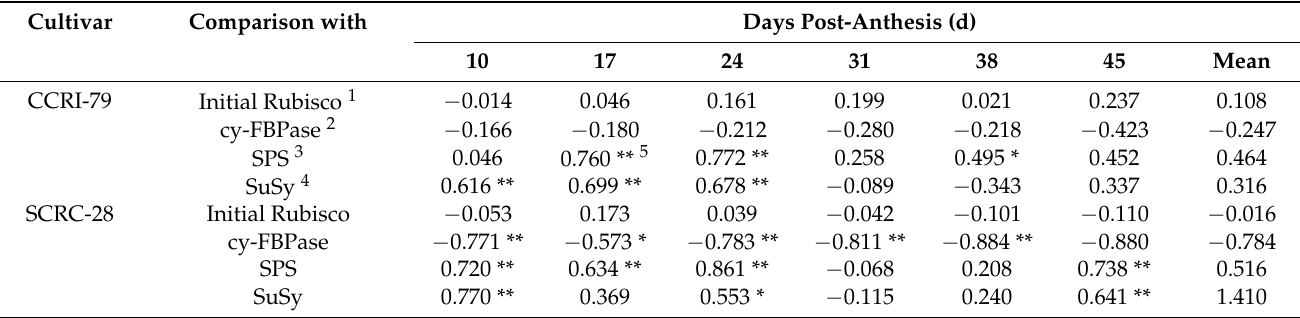
Table 4. Correlation between sucrose-metabolizing enzyme activity and P concentration in